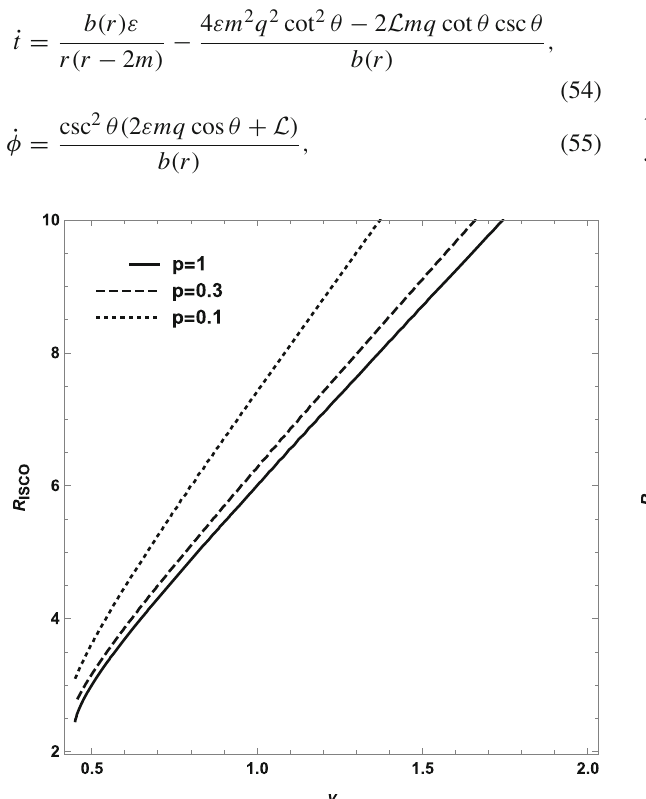
different values of γ . For comparison we include the ISCO for Kerr and NUT. The parameter a corresponds to the rotation parameter of the Kerr metric and l corresponds to the gravitomagnetic charge of the NUT metric in the usual